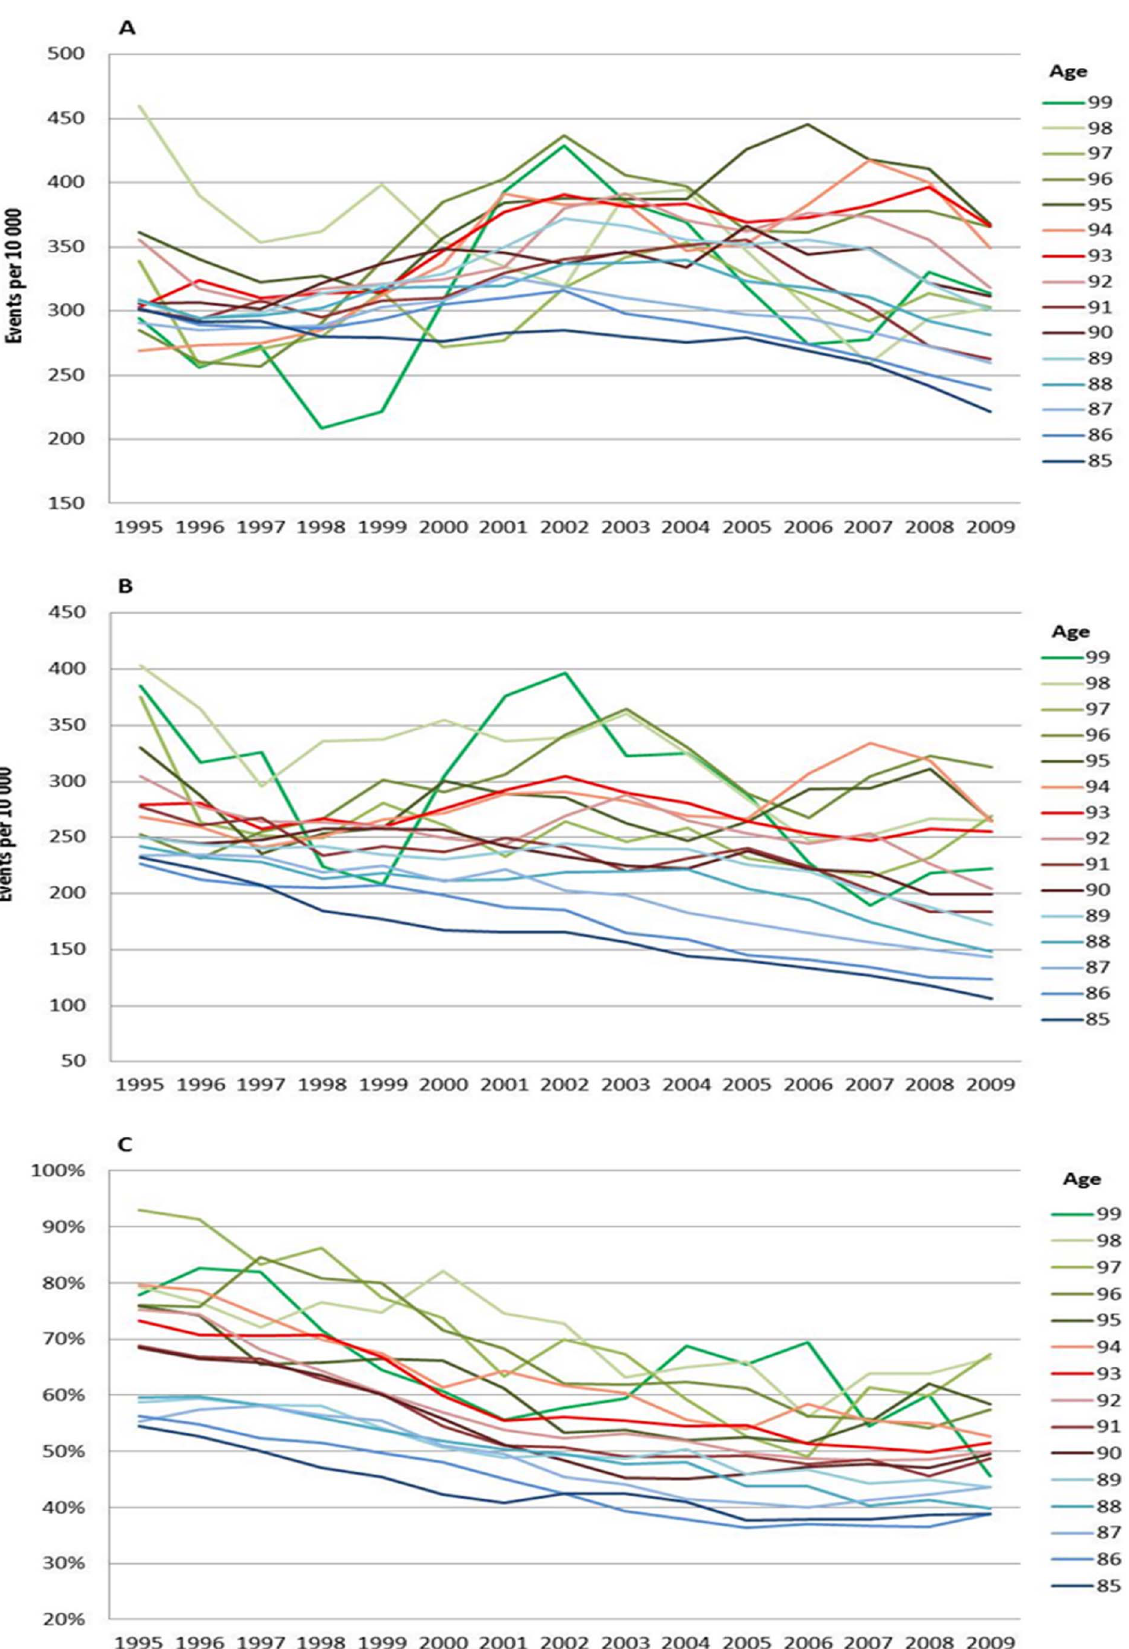
Figure 3. MI incidence (A), mortality (B) and case fatality (C), men. Age specific trends in myocardial infarction, men, between 1994 and 2010. One year cumulative incidence (A), overall mortality (B), and, case fatality within 28 days, percent (C). Three year moving average. doi:10.1371/journal.pone.0064928.g003 PLOS ONE |